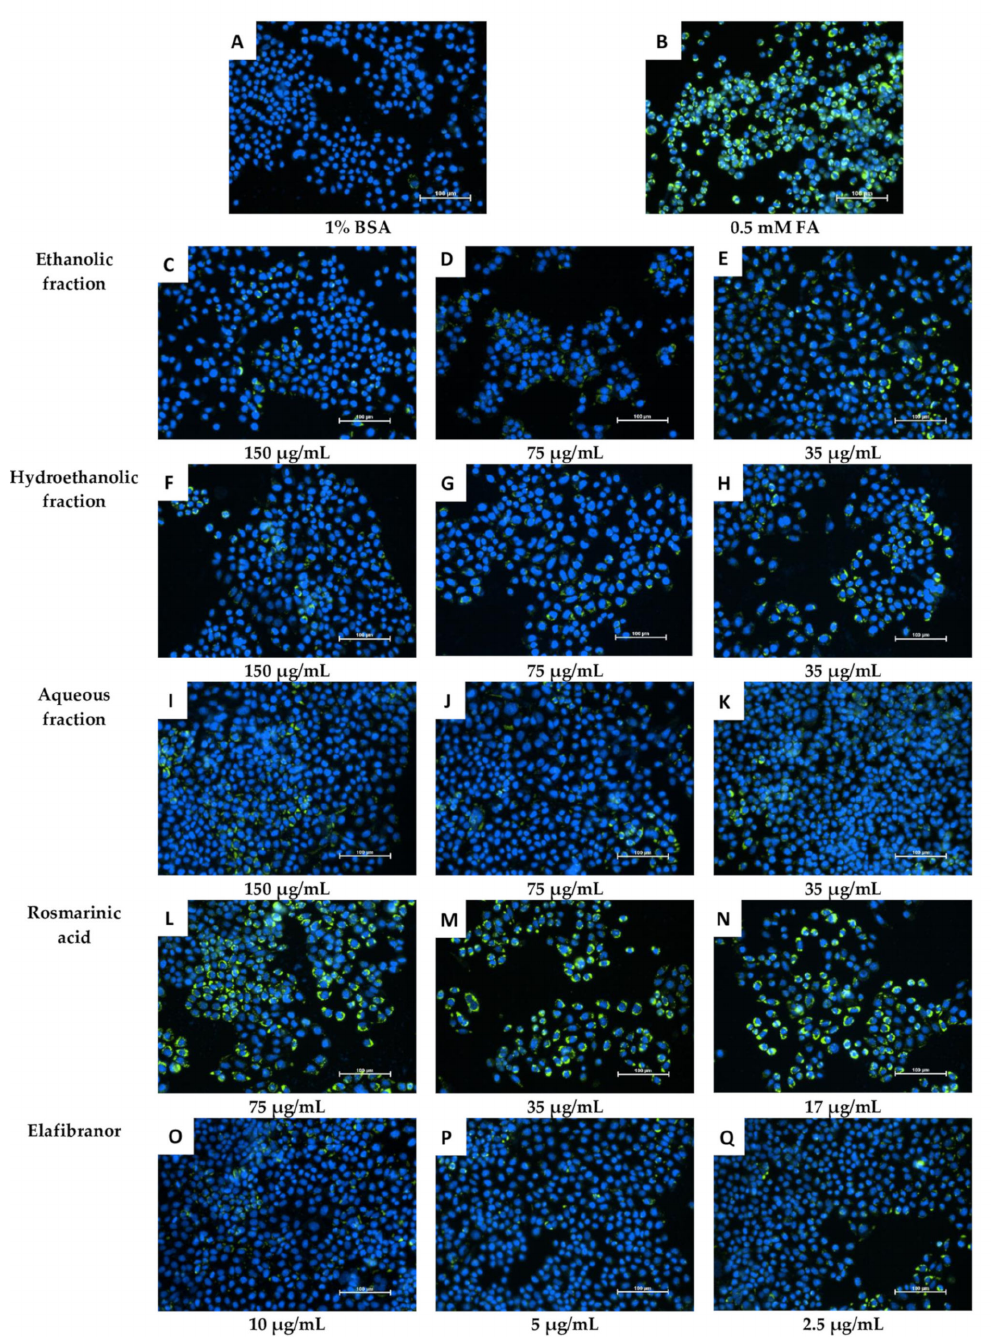
Figure 10. Microscopic examination of the effect of O. aristatus fractions on the intracellular lipid accumulation (24 h). The green colour is the Nile Red stain (FITC filter) indicating the fat droplet inside the cells and the blue colour is Hoechst 33342 (DAPI filter) as a nuclear counterstain. The scale bar is 100 µ m (20 ×